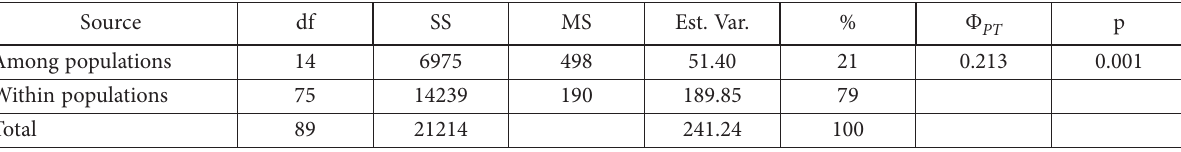
Geographical distance (km) Figure 2. AFLP loci-based Mantel test of correlation between Nei’s genetic and geographic distances for 15 Lithuanian populations of L. salicaria Table 4. AFLP loci based molecular variance (AMOVA) of Lithuanian populations of Lythrum salicaria Source df SS MS Est. Var.